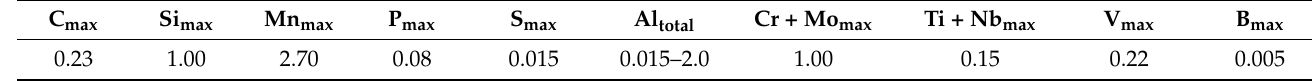
Table 1. Chemical composition of CP1000 steel samples.